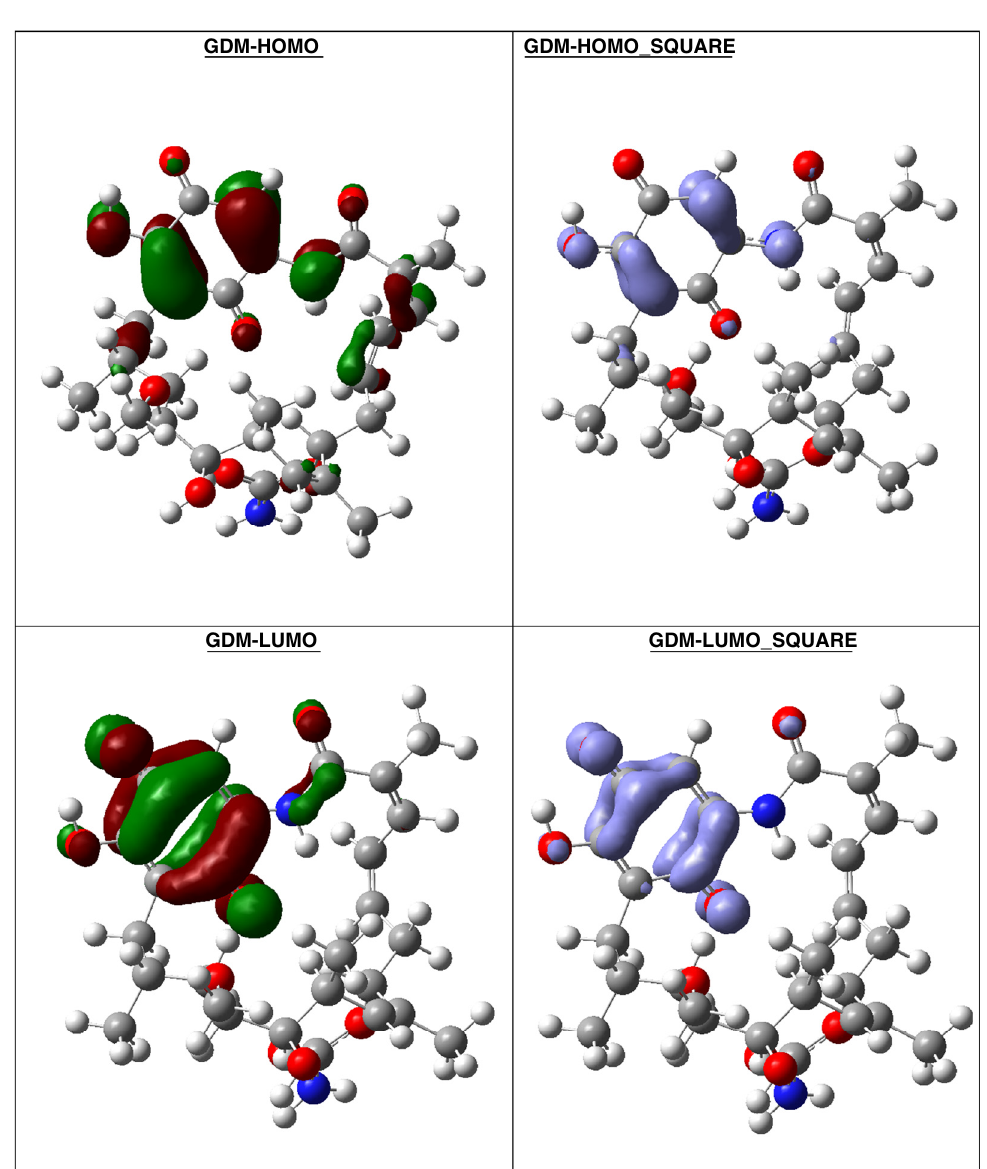
Figure 18. Frontier molecular orbitals HOMO, LUMO (isosurface 0.02), the Fukui Functions 2 0.004), to reference compound